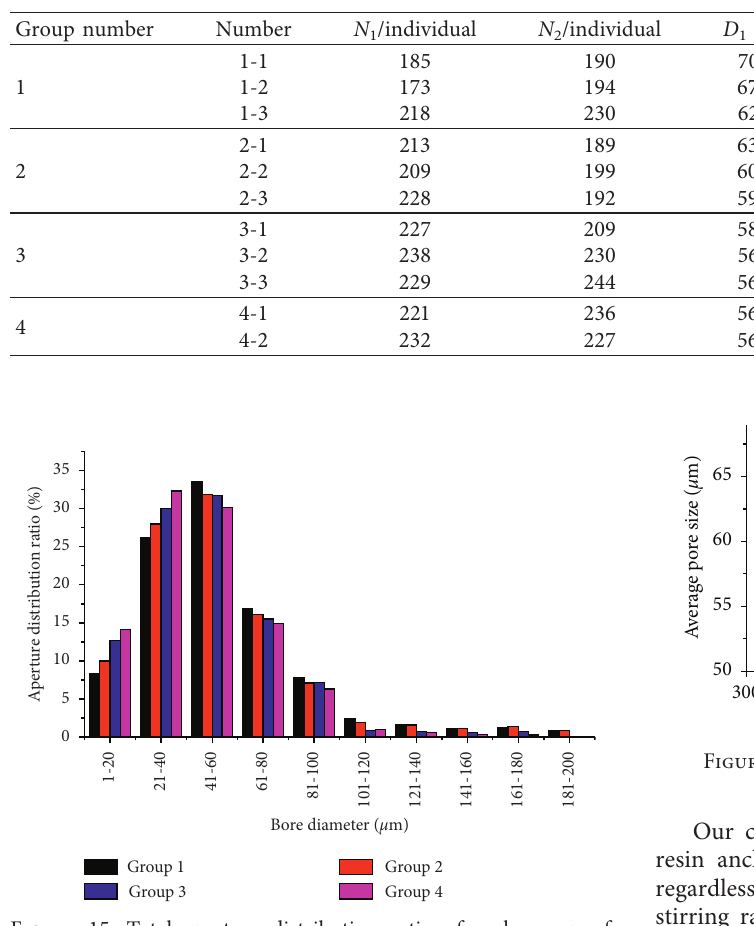
Figure 14: Preprocessing of sectional face structure. Table 3: Characterization of specimens aperture data.